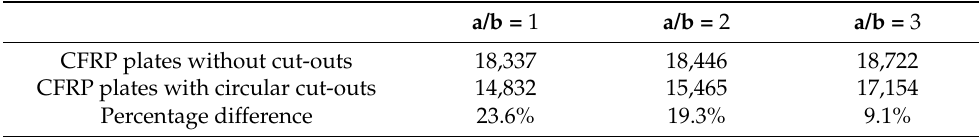
Table 2. Buckling load comparison in [N].